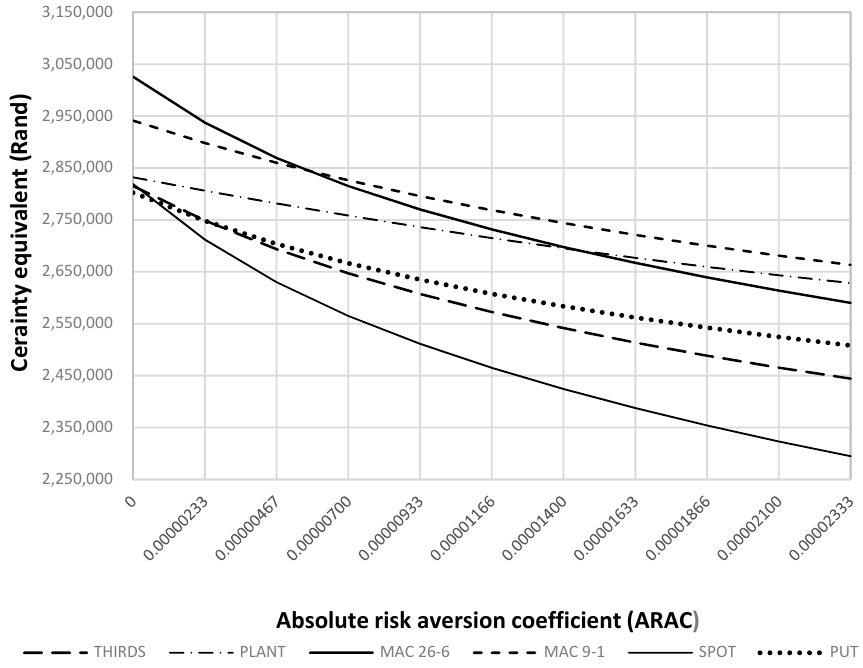
Figure 6. Stochastic efficiency ranking of the alternative marketing strategies. Source: Author’s Compilation.